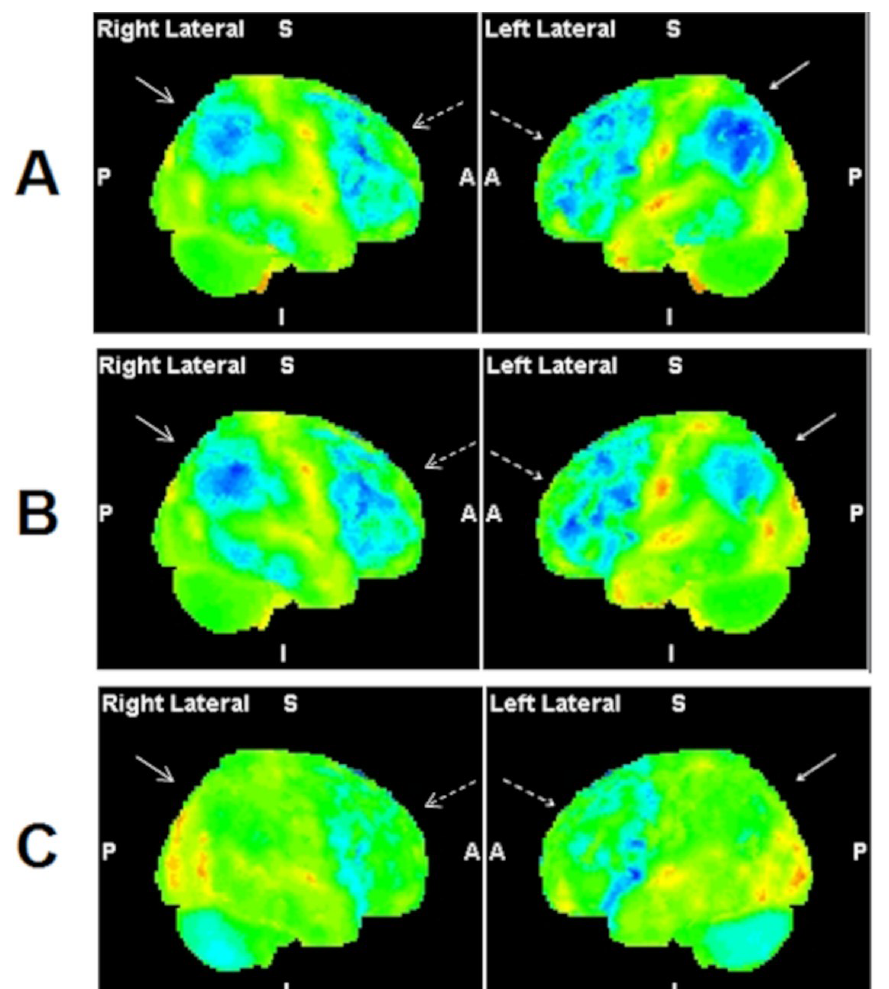
Figure 1. Quantitative analysis of the 18 F-FDG PET/CT images (Scenium ® software, Siemens CTI Molecular Imaging, Knoxville, TN, USA). The software conducts a voxel-by-voxel statistical comparison of patient’s PET/CT with a control group. The quantitative analysis delineates areas of significant hypometabolism (>2 SDs from the mean) and depicts them in color tridimensional images. Regions with normal and reduced glucose metabolism are displayed in green and blue, respectively. (A) Right and left lateral projections of quantitative images obtained during acute lithium intoxication show marked bilateral hypometabolism of the parietal lobes (arrows) and moderate hypometabolism of frontal lobes (dashed arrows). (B) Images obtained on the sixth day after lithium withdrawal show a significant improvement of glucose metabolism in the left parietal lobe (arrow), with hypometabolism persisting in the right parietal and frontal lobes (dashed arrows). (C) Two months after lithium discontinuation, complete resolution of glucose metabolism is evident in the parietal lobes (arrows), with only mild hypometabolism of the frontal lobes persisting (dashed Mecê AM, et al. Lithium and rapidly progressive dementia.